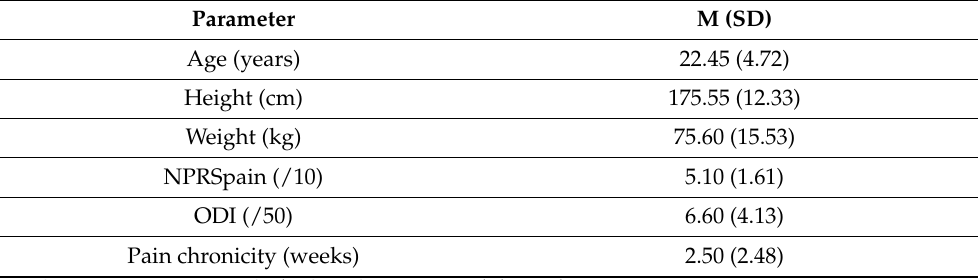
Table 1. Demographics of patients with low back pain ( n = 20, m/f